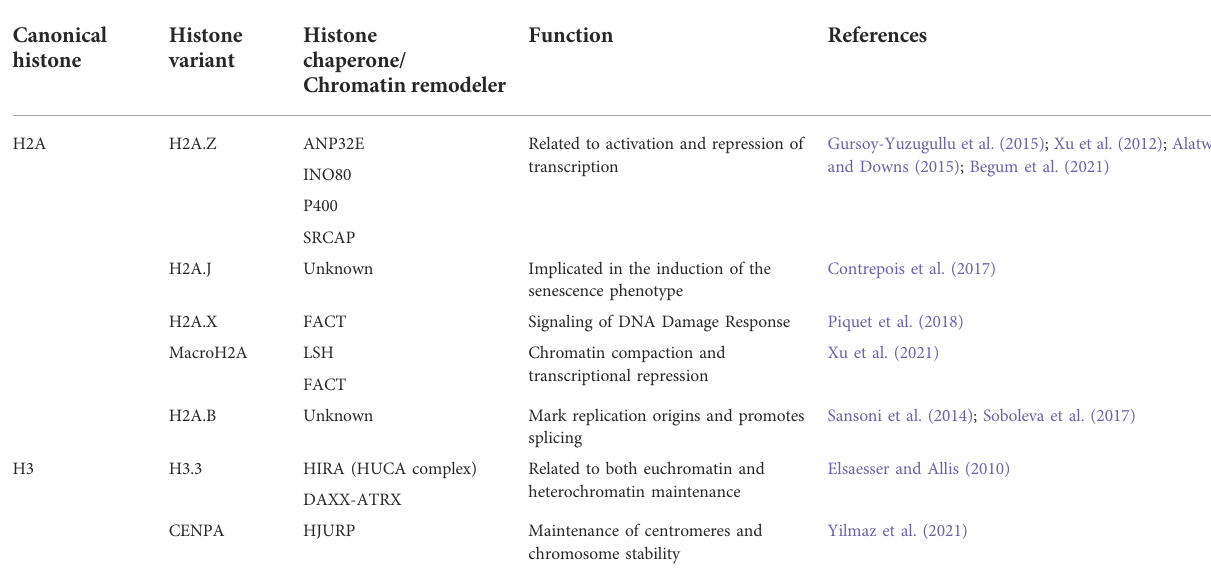
TABLE 1 Principal functions of H2A and H3